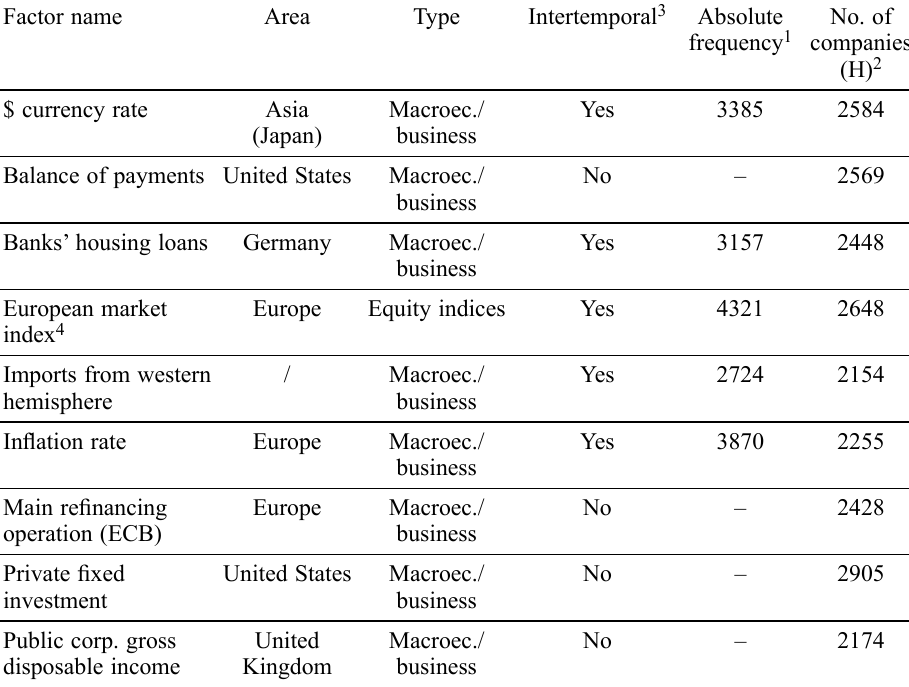
Table 3. First 15 most important factors identified by the analysis in period H